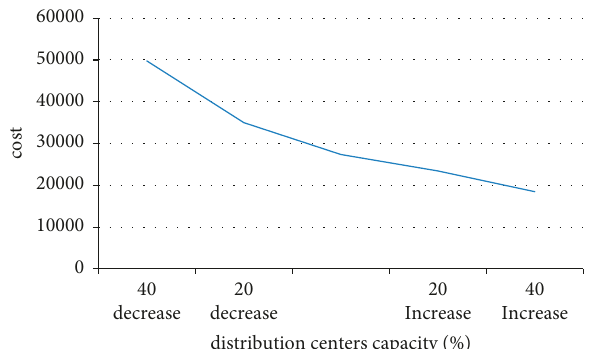
Figure 6: Sensitivity analysis of the objective function relative to the capacity of distribution centers.